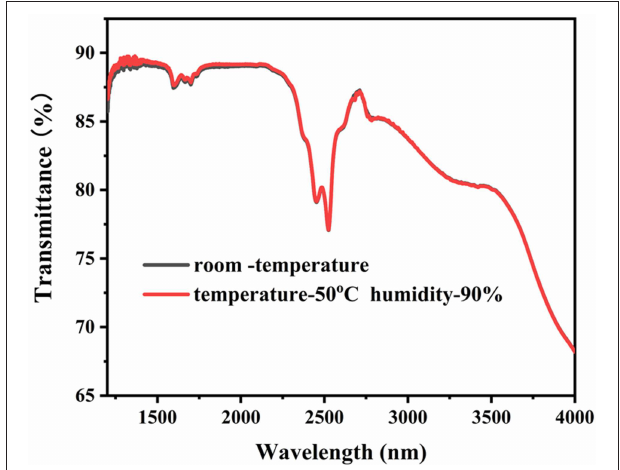
FIGURE 6 | Transmittance spectra of the Nd 3 ± doped fluorosilicate glass at room temperature (black) and after treatment at T ∼ 50 ◦ C, ∼ 90% humidity for 2h